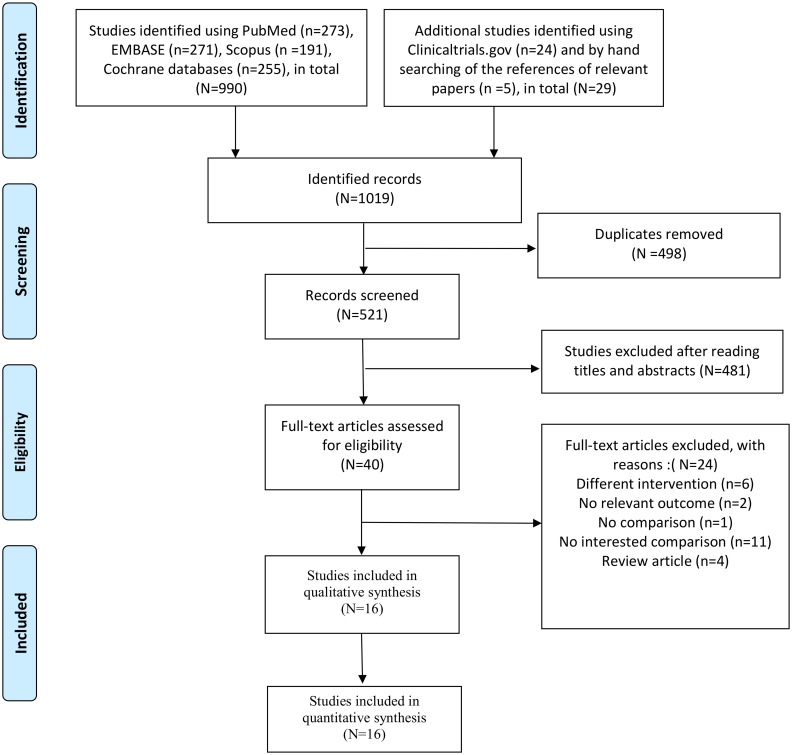
Flow diagram of the search process and search results.